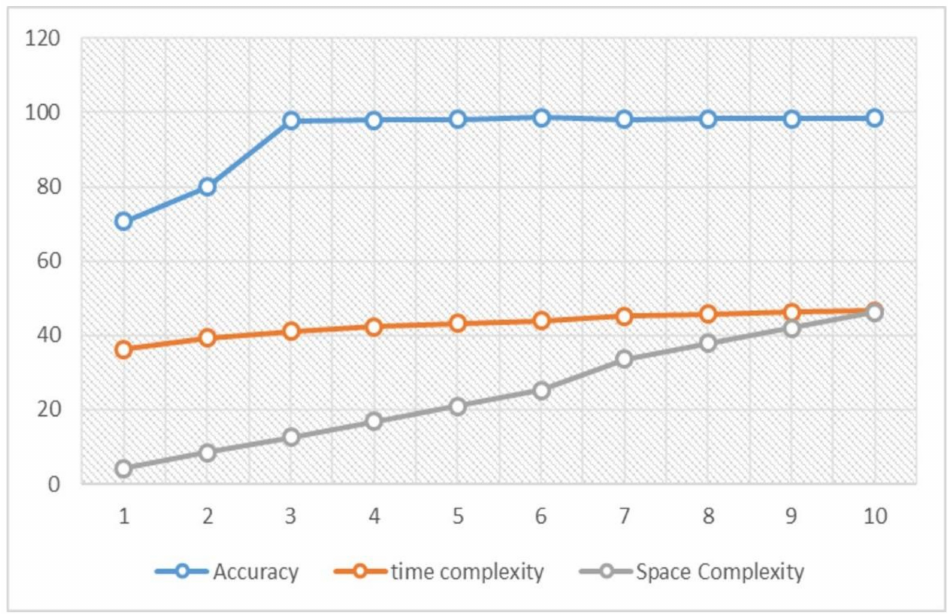
Figure 2. RF Accuracy, Time and Space Complexities with Respect to Number of